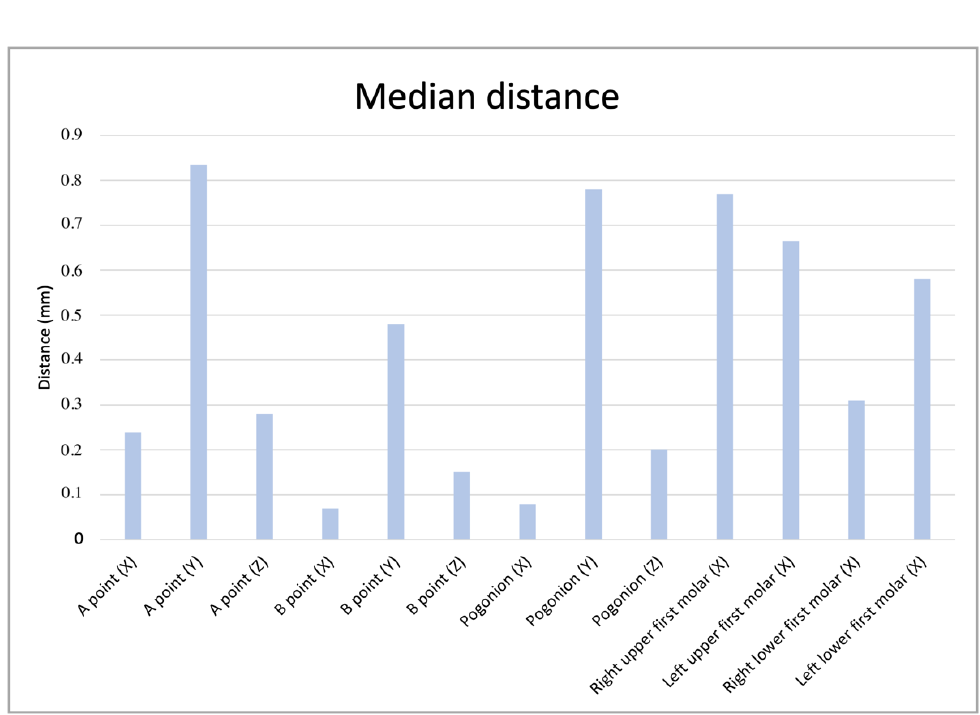
Figure 6. Median distance (mm) for all cephalometric points in the x , y , and z axes. The x axis represents the mediolateral (or horizontal) direction, the y axis, the anteroposterior direction, and the z axis, the inferosuperior (or vertical) direction.